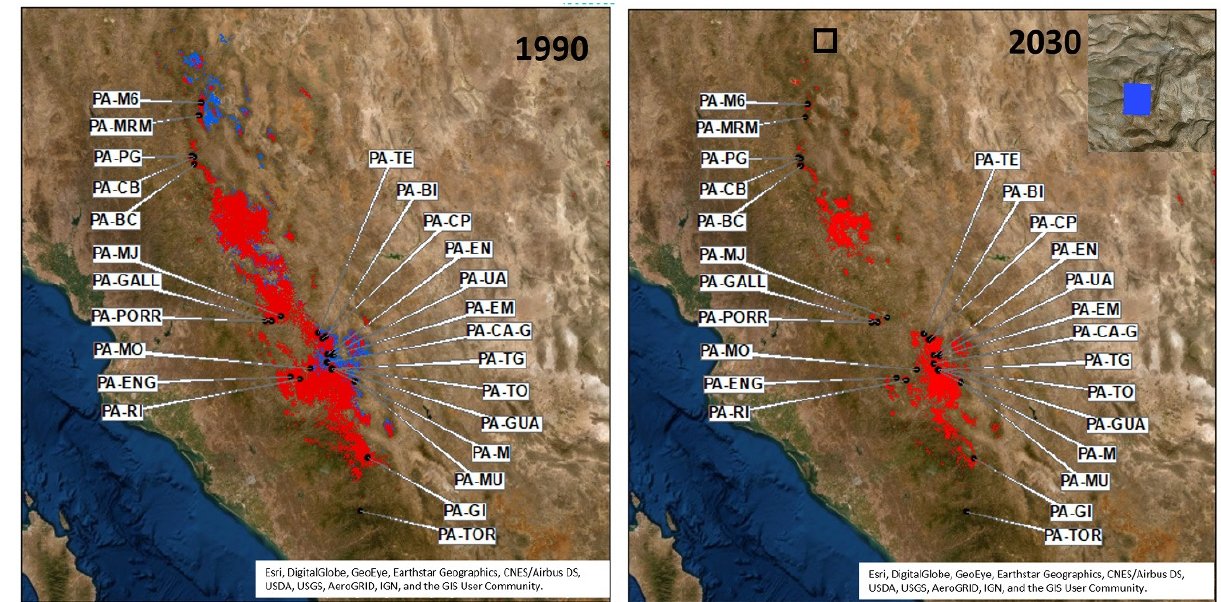
Figure 4. Projection for 1990 and 2030 climatic frames of two seed zones of Pinus arizonica based on the relative frequency distribution of AFLP outlier 351; modelling based on spring precipitation (mm) (see Table 1) . The species distribution was modeled by 18 environmental variables and the Random Forest classifier (Tables S5, S6 and S7a,b); the threshold for probability of presence (PoP) was 0.30; black points = P. arizonica seed stands studied here (Table S3a); blue color = relative frequency of the AFLP outlier locus 351 between 0.0 and 0.50; and red color = relative frequency of the AFLP outlier locus 351 between 0.51 and 1.0.